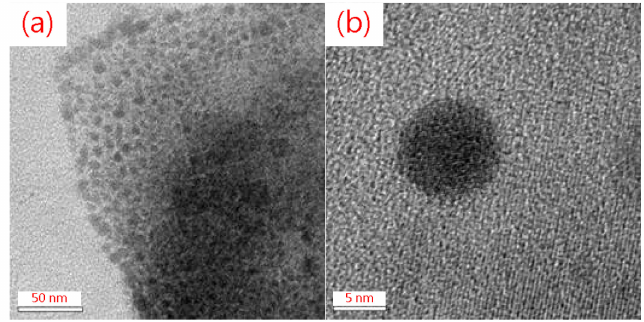
Figure 4. TEM images of the QD-MAPbBr 3 ( a ) particle and ( b ) quantum dot.